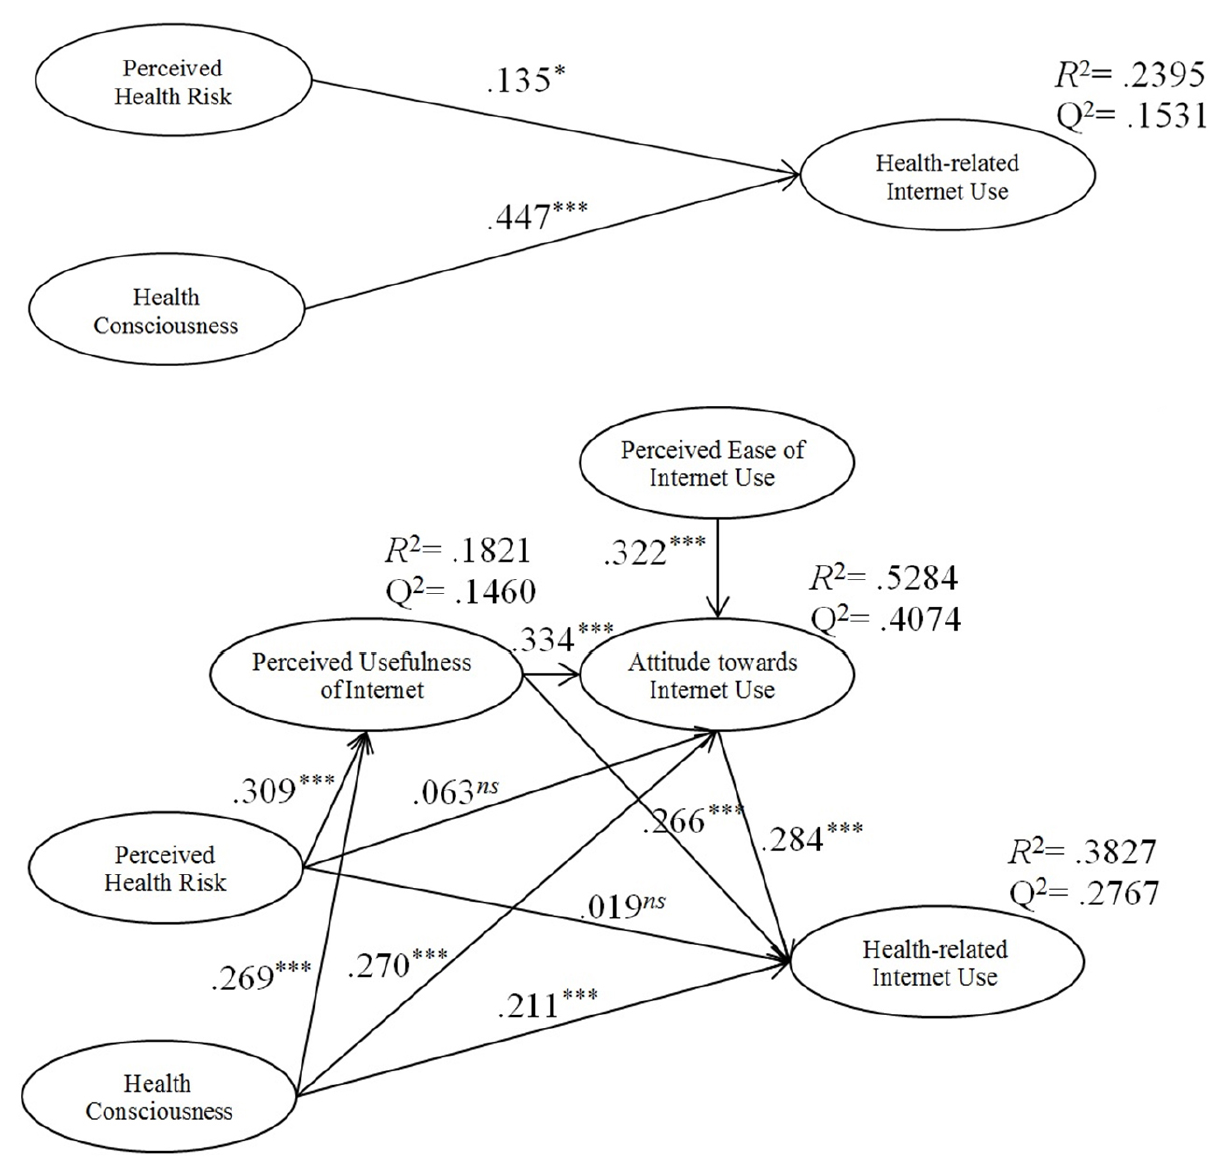
Figure 5. Path coefficients of the structural research